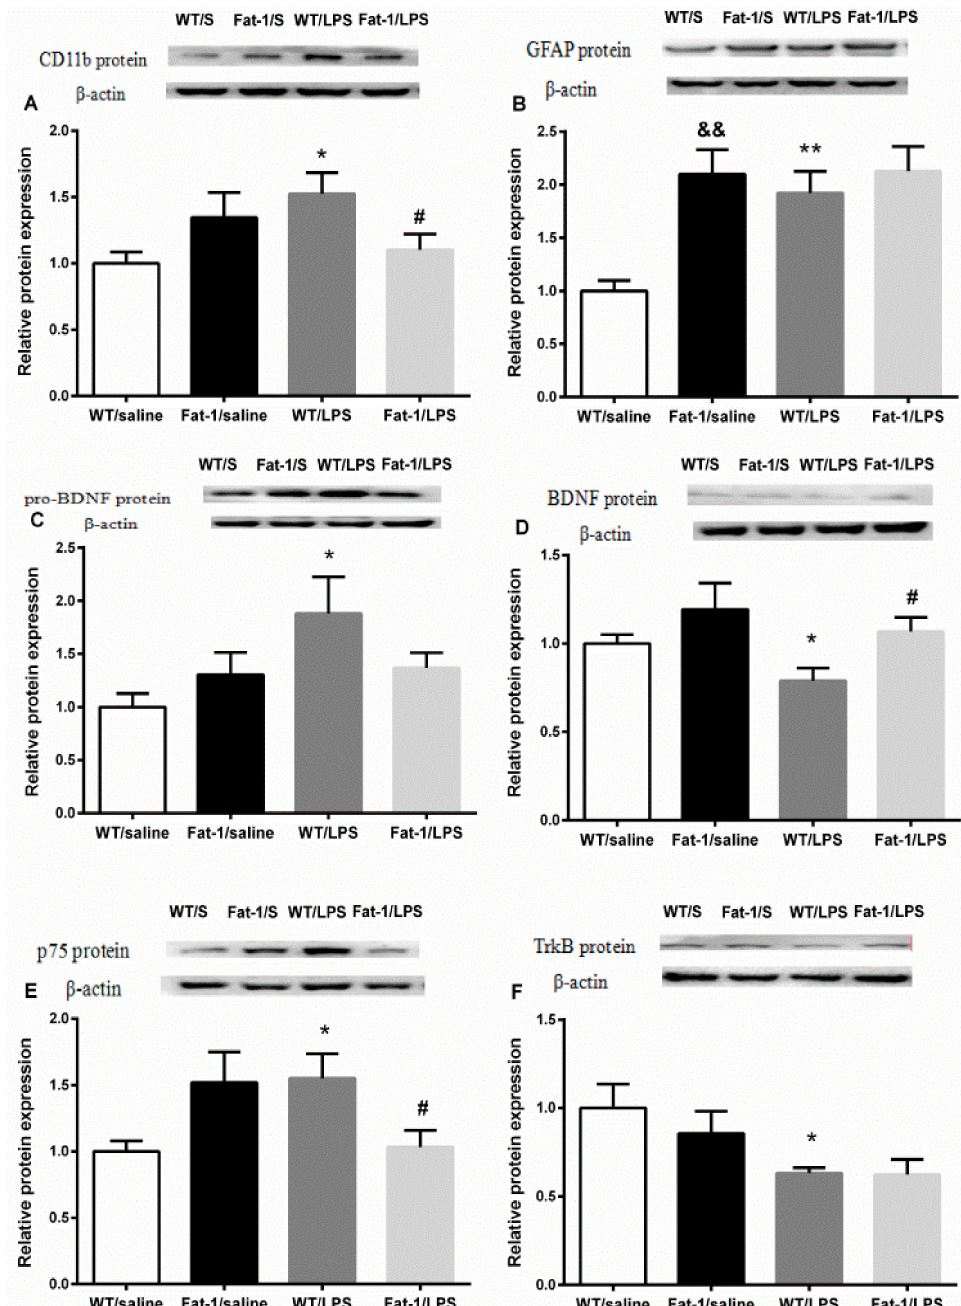
Figure 9. LPS significantly up-regulated the protein expression of CD11b, GFAP, p75, and pro-BDNF, but down-regulated protein expression of BDNF and Trk B in the animal model. The protein expression of GFAP was increased in Fat-1 mice when compared with wild-type mice. The rise in the protein expression of CD11b and p75 was prevented, and there was an up-regulation of BDNF level at the same time in Fat-1 mice. ( A ) CD11b; ( B ) GFAP; ( C ) pro-BDNF; ( D ) BDNF; ( E ) Trk B; ( F ) p75. * p < 0.05, ** p < 0.01 vs. WT/saline; # p < 0.05 vs. WT/LPS; && p < 0.01 vs. Fat-1/saline. LPS: lipopolysaccharides; WT: Wild-type. S: